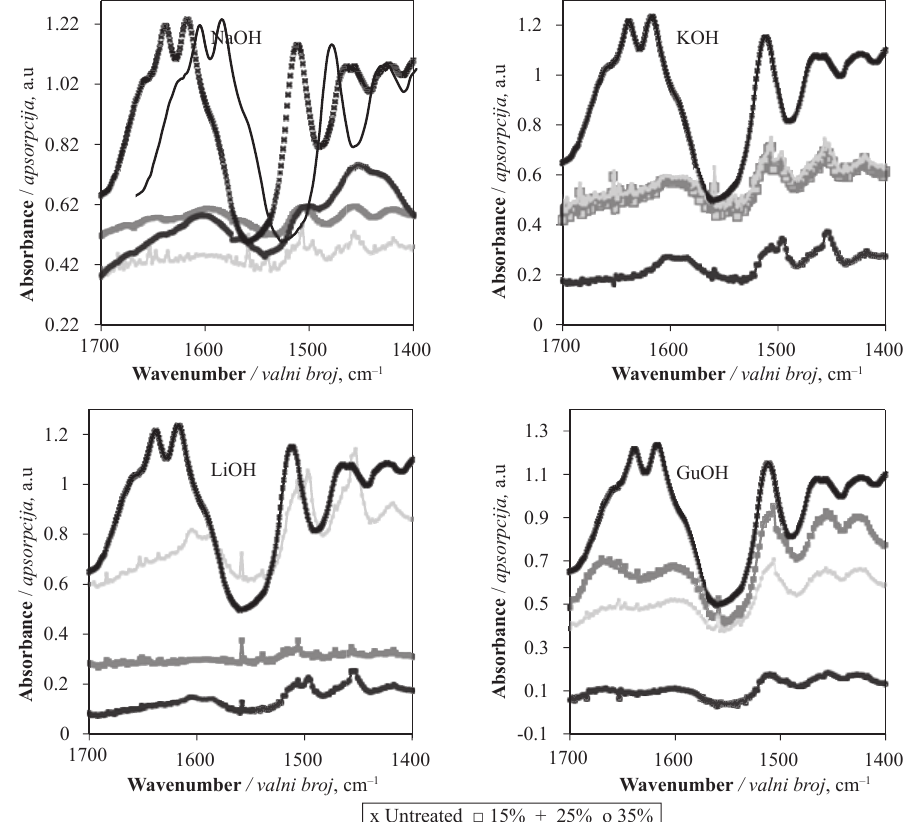
Figure 4 Increase of aromatic C-C axial deformations around 1595 cm -1 due to benyzlation Slika 4 . Porast aromatske C-C aksijalne deformacije oko 1595 cm -1 zbog benzilacije